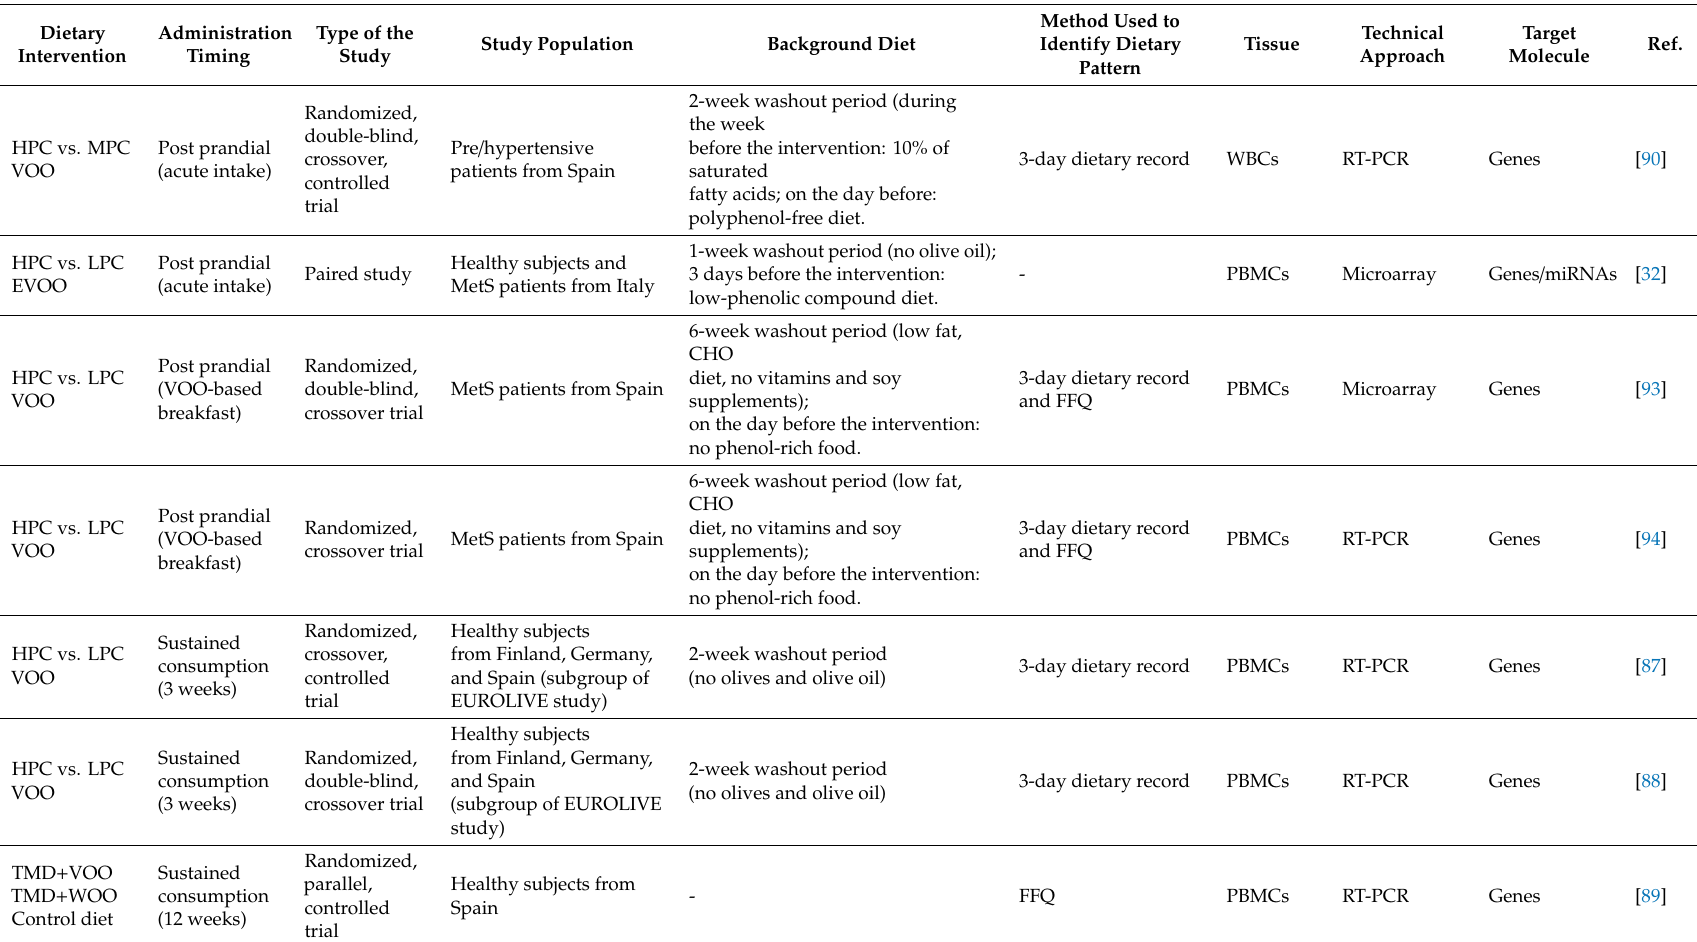
Table 2. Transcriptomic studies describing the impact of VOO and EVOO characterized by di ff erent polyphenol content on human population. Dietary Administration Type of the Study Population Background Diet Intervention Timing Study